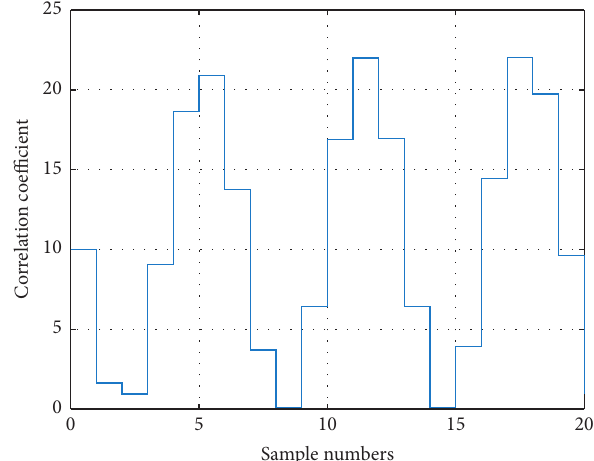
Figure 6: Ladder diagram of the correlation coefficient of the evolutionary game.